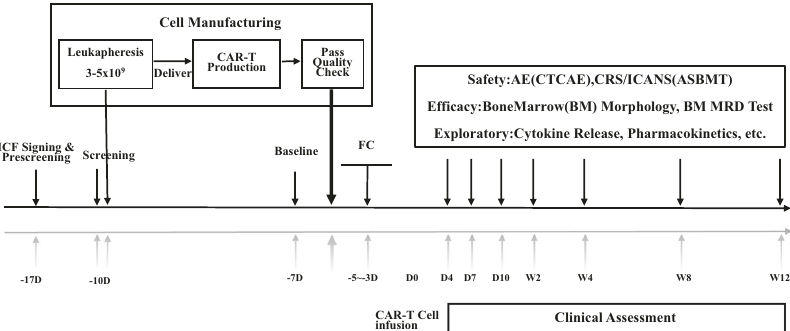
Fig. 1 Clinical study schema. After screening the patients and signing informed consent form, the PBMCs were collected by leukapheresis. The GC007F cells were constructed and infused into patients after conditioning regimens. The pharmacokinetics, response assessment and adverse events were observed. ICF Informed consent form, PBMCs peripheral blood mononuclear cells, MRD minimal residual disease, AE advert effect, CRS cytokine release syndrome, ICANS immune effector cell-associated neurotoxicity syndrome, CTCAE common terminology criteria for adverse events, ASBMT American society for blood and marrow transplantation.